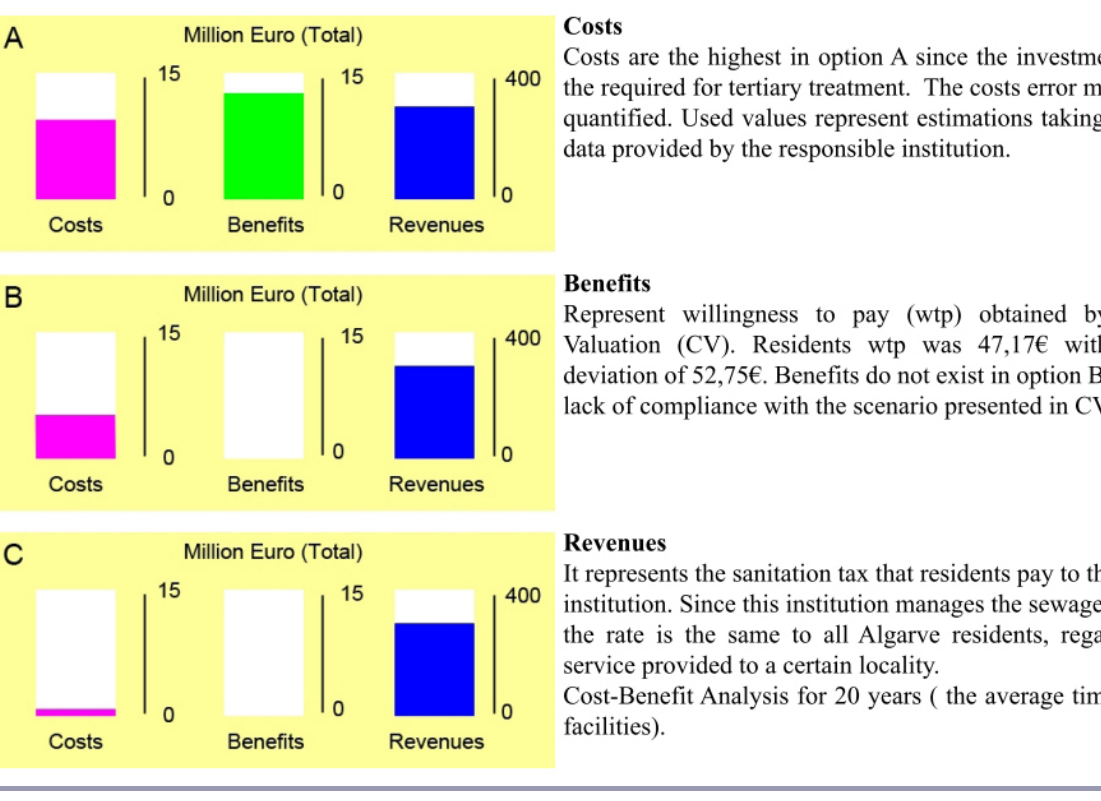
Fig. 7 . CBA outputs in GUADEX environment according to the three wastewater treatment efficiency scenarios for coliform removal: A – 99%; B – 50%; C – 10%. The final output represents the cost/benefit ratio taking into account a 20-year